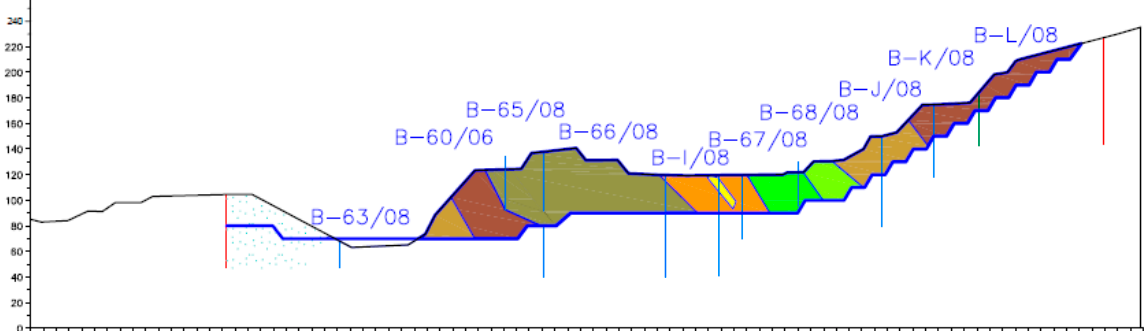
Figure 5. Transversal geological cross-sections 5–5 ′ and 19–19 ′ .